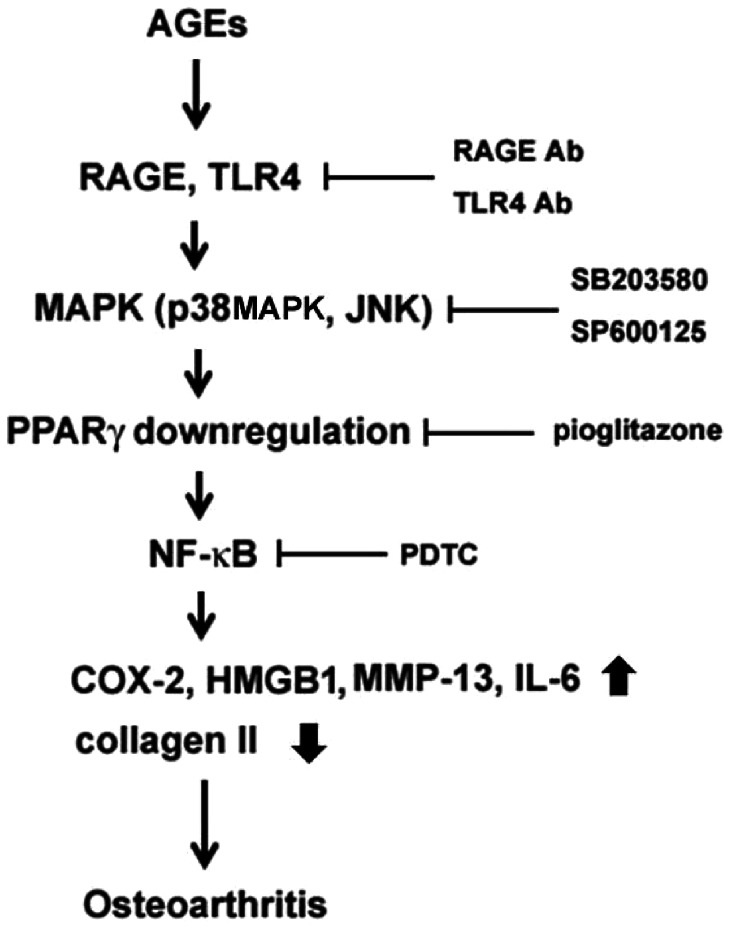
The proposed schematic representation of AGEs-induced inflammatory signalings and resulted reduction of collagen II expression mediated by the down-regulation of PPARγ via TLR4 and RAGE in human OA chondrocytes is shown.